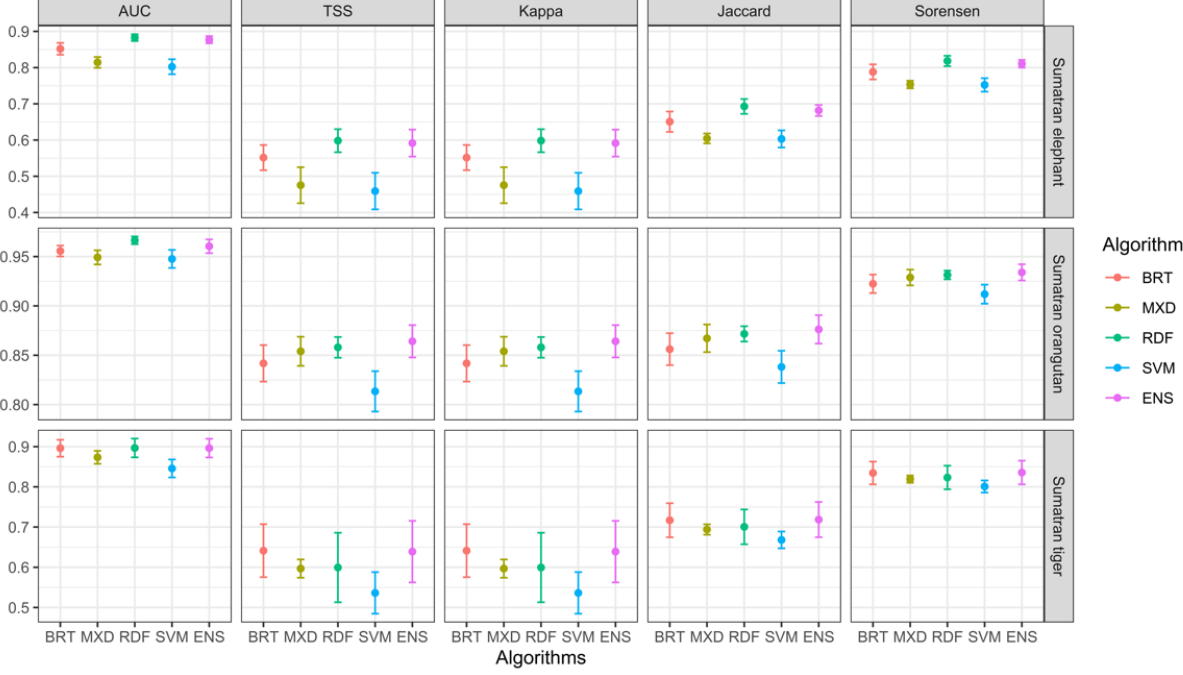
Table 1. Contribution of each variable for the best model (Ensemble).